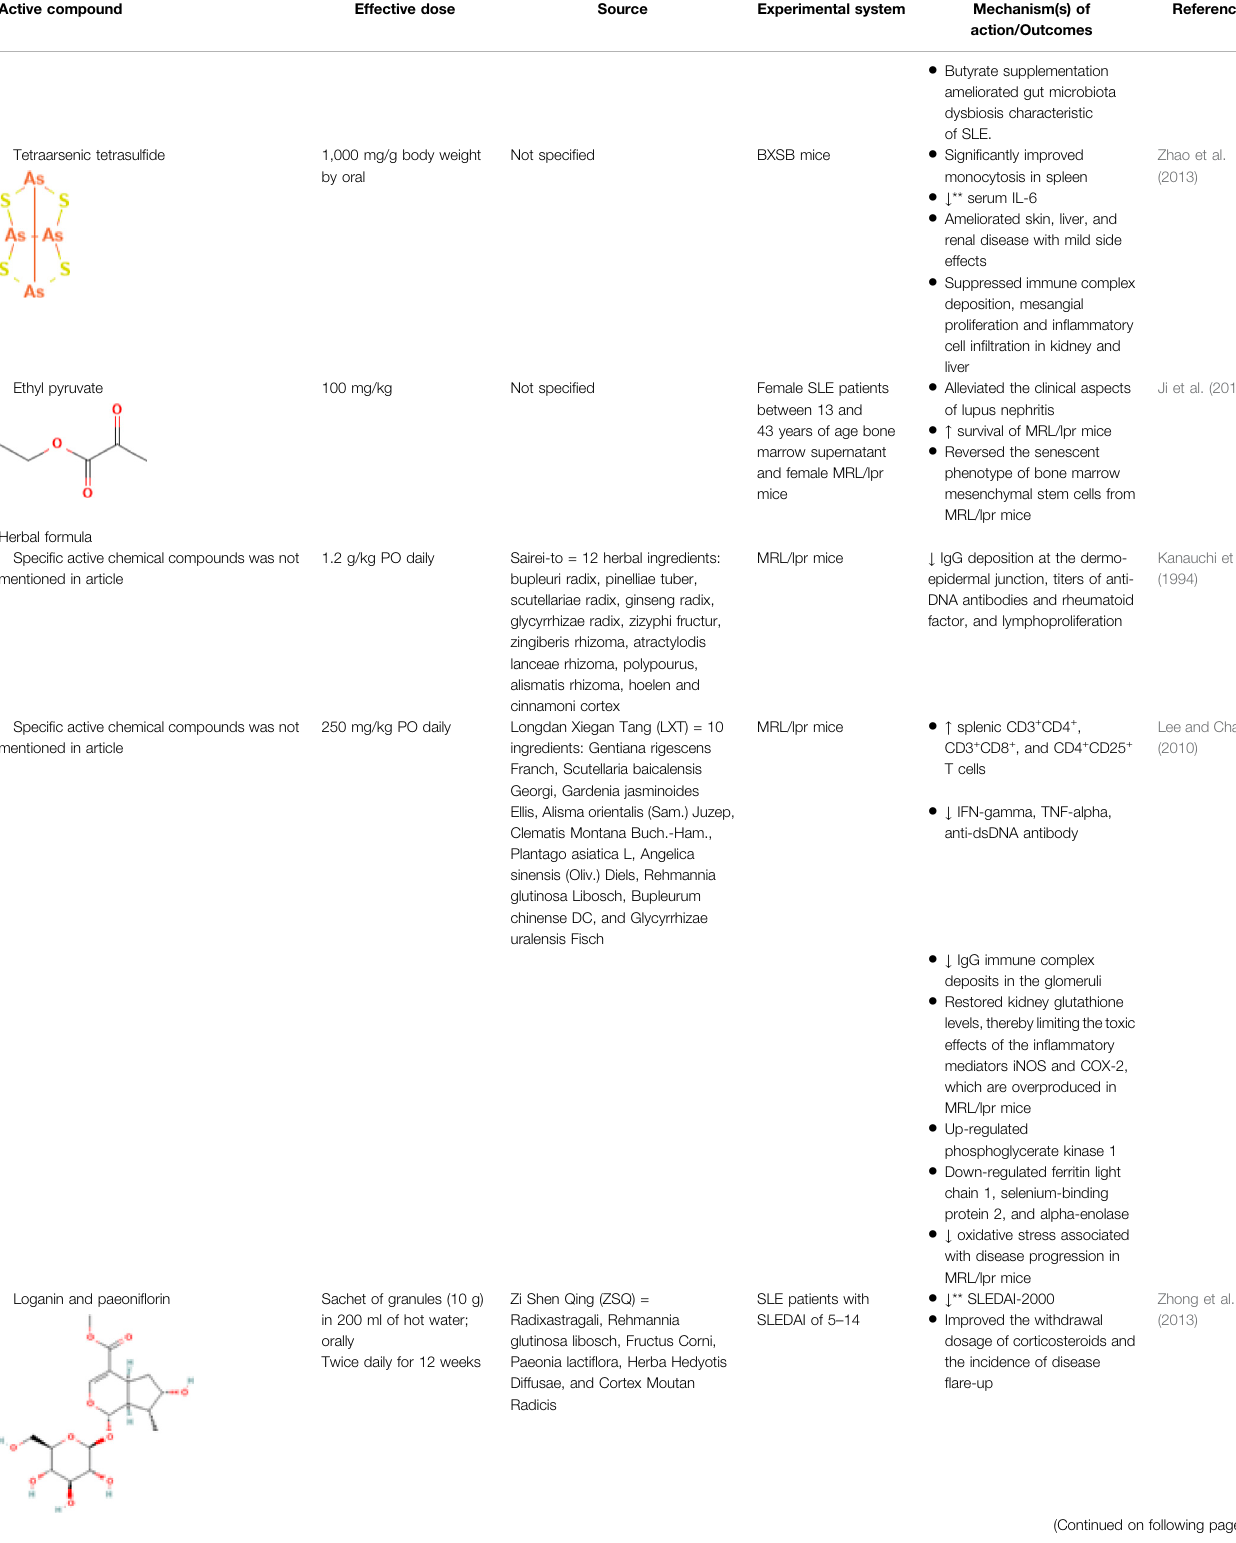
TABLE 1 | ( Continued ) Synthesized fi ndings for potential bioactive compounds for CLE.